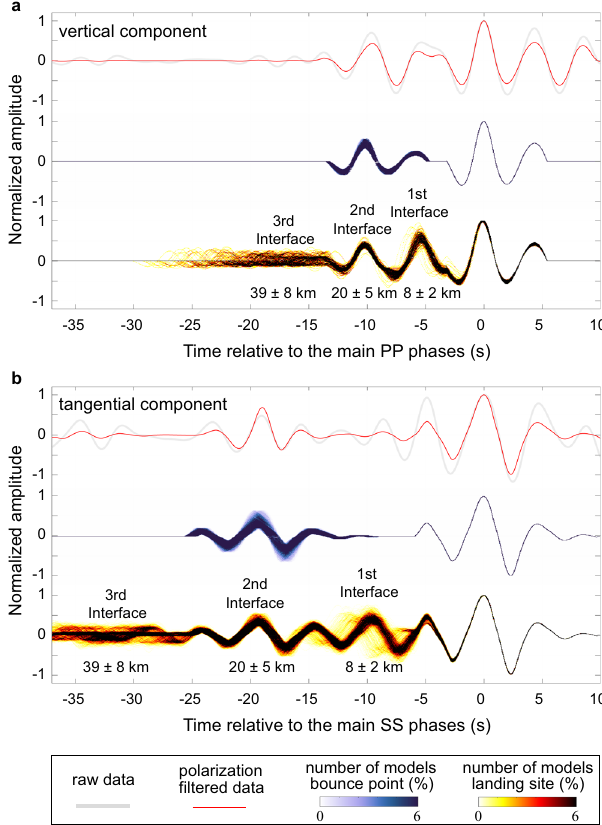
Fig.3|Seismicobservationsandsyntheticwaveform fi ts.a Thetraceonthetop panel (in red) is the PP wave train on the vertical component after polarization fi ltering, and the raw displacement record is also shown in light grey. The wave- forms on the middle panel are the synthetic waveforms using the inverted models at the bounce point (shown in Fig. 4c). The seismograms on the bottom panel are synthetics using the receiver-function-derived models at the InSight landing site 11 (see Methods section for the synthetic waveform calculation). b Similar to ( a ), but for the SS wave train on the tangential